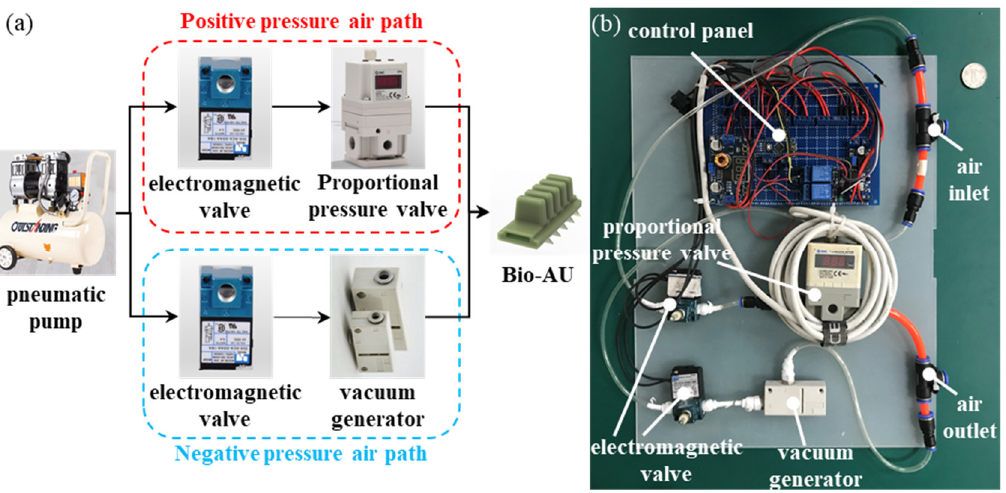
Figure 7. Pneumatic drive system: ( a ) functional block diagram; and ( b ) physical connection dia- gram.